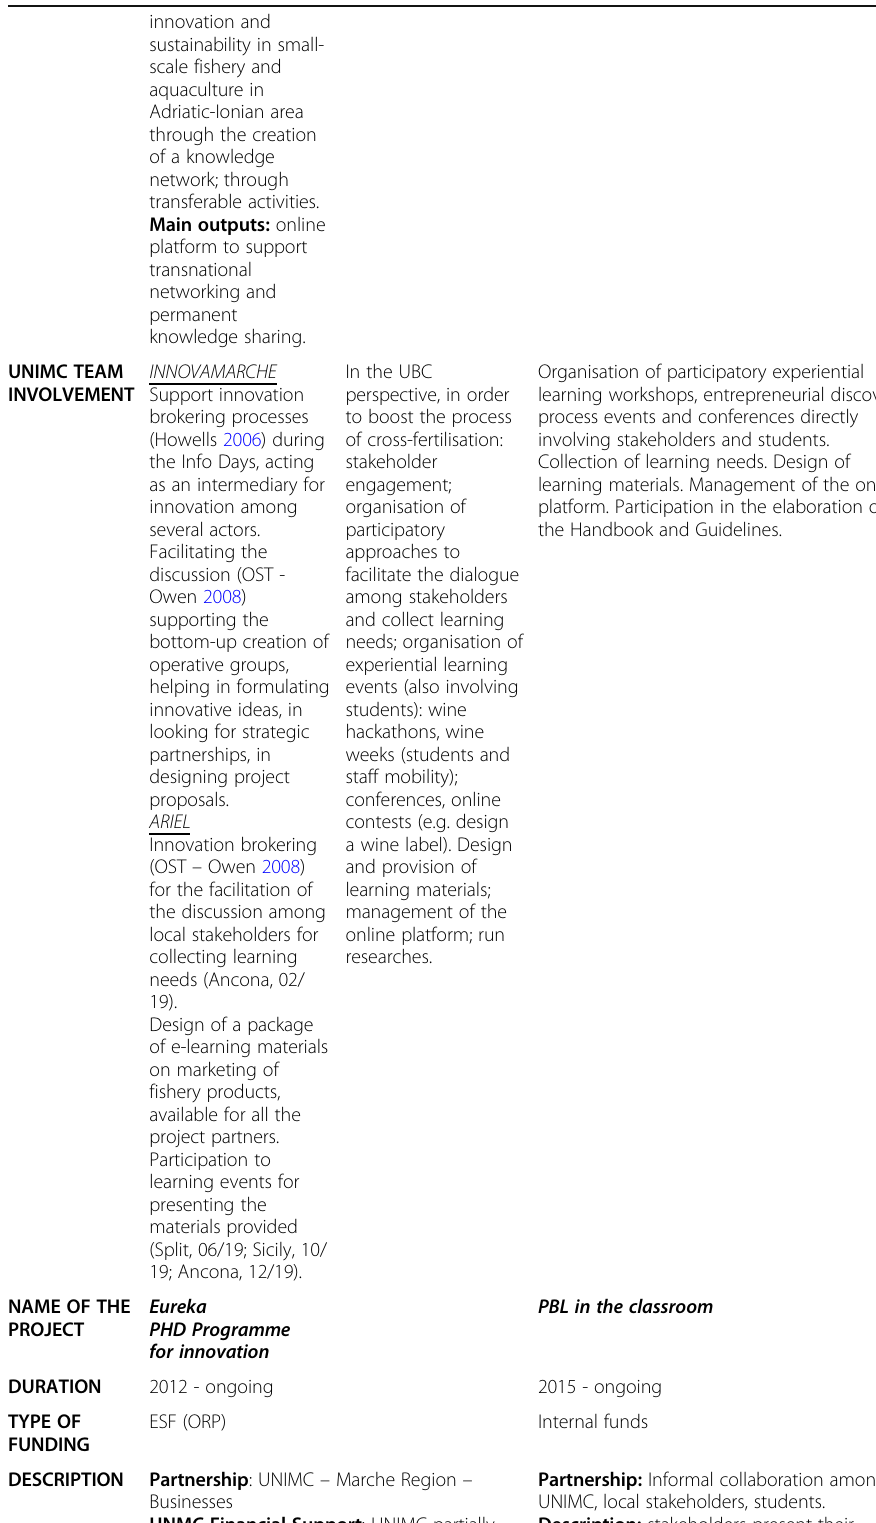
Table 2 Overview about the projects representing UNIMC ’ s civic engagement (own elaboration)